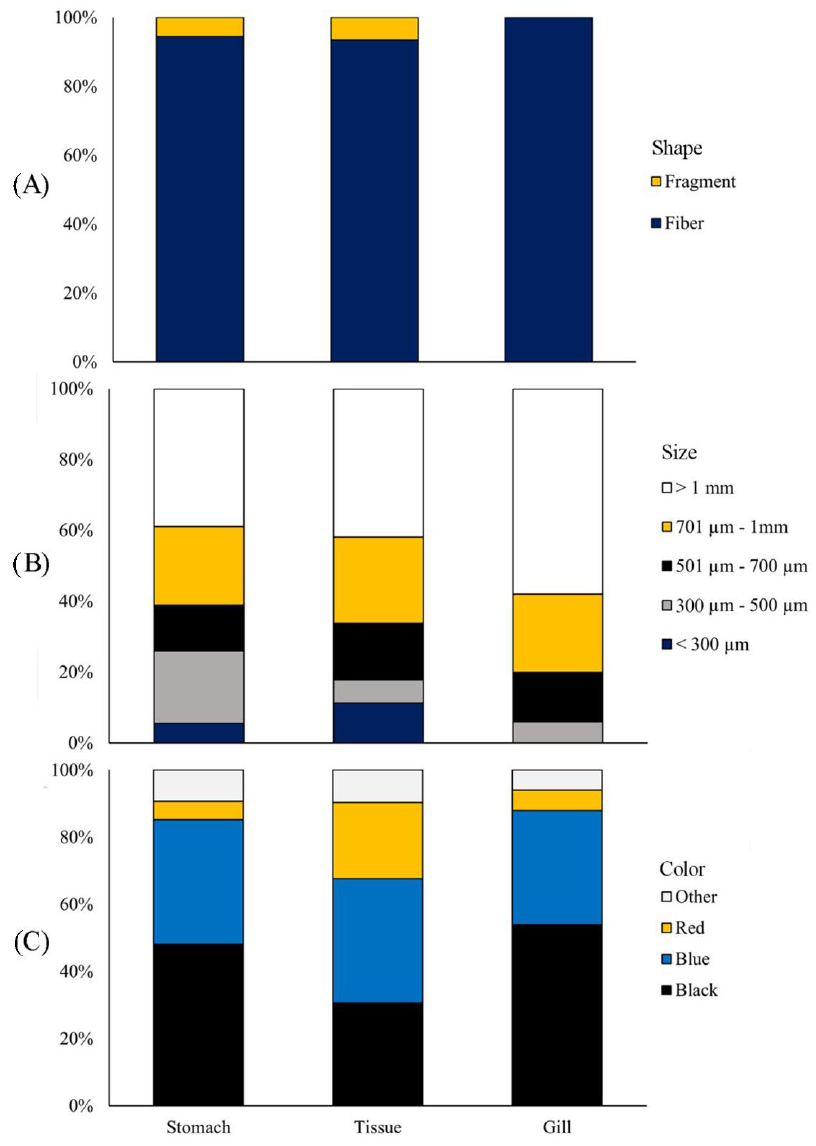
Figure 3 . Distribution of microplastic characteristics in this study : ( A ) shape; ( B ) size; ( C ) color in the stomach, flesh, and gills of the soldier catfish O . militaris .